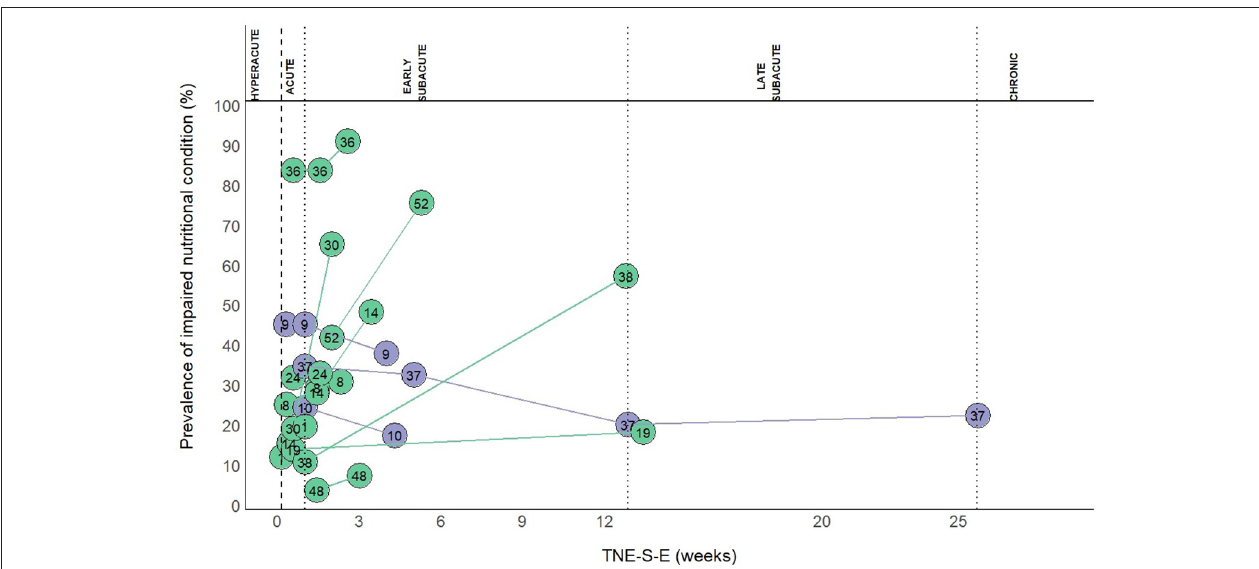
FIGURE 5 | Prevalence of INC at follow-up. Numbers in the plot indicate the references to the study groups: 1, Yoo 2008 (2); 8, Diendéré 2020 (36); 9, Vajpayee 2008 ( 37); 10, Gandolfo 2019 (38); 14, Zheng 2015 II (41); 19, Barrio 2020 (46); 24, Crary 2013 (51); 30, Mosselman 2013 (56); 36, Far 2018 (62); 37, Brynningsen 2007 (63); 38, Kokura 2018 (64); 48, Zhang 2015 (73); 52, Sato 2019 (77).